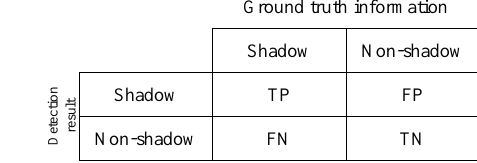
Figure 7. Confusion matrix for shadow detection